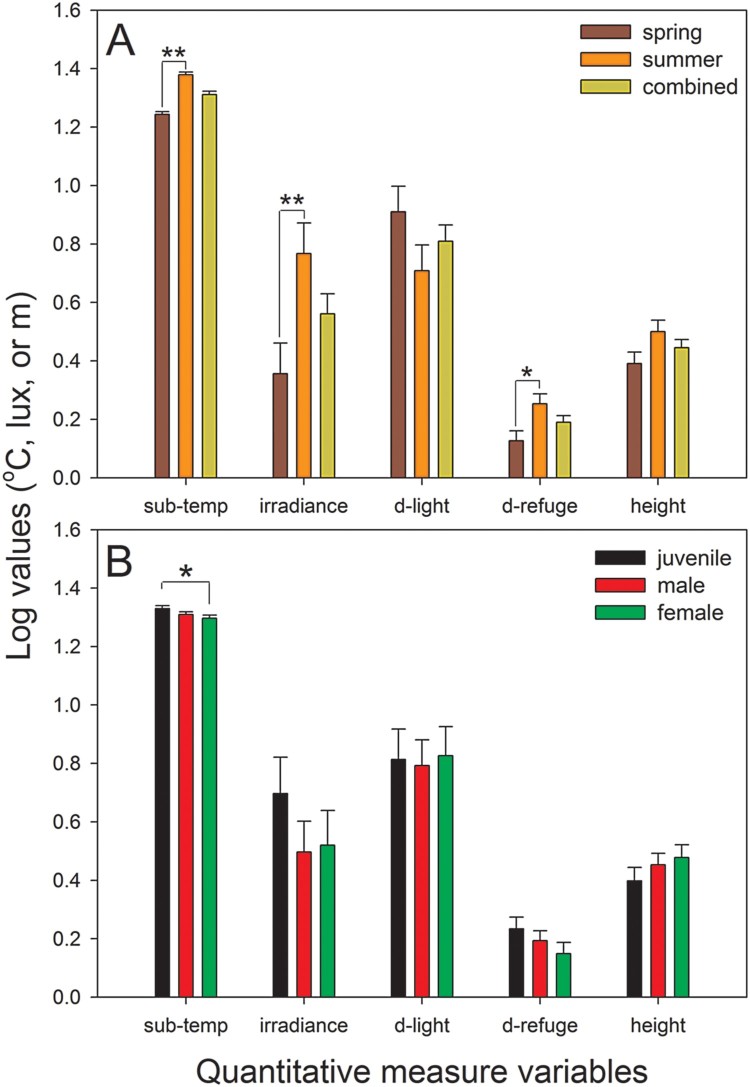
Comparison of the microhabitat use of G. japonicus in terms of quantitative measure variables between spring and summer (a) and among different reproductive groups (b). ‘Combined’ in panel A indicates the combined data from two seasons. The data are the estimated marginal means +1 SE, which considered covariates in the analysis model. Sub-temp, substrate temperature where geckos were observed; d-light, distance to the main light source illuminating the geckos; d-refuge, distance to the nearest potential refuge. *P < 0.05; **P < 0.01.